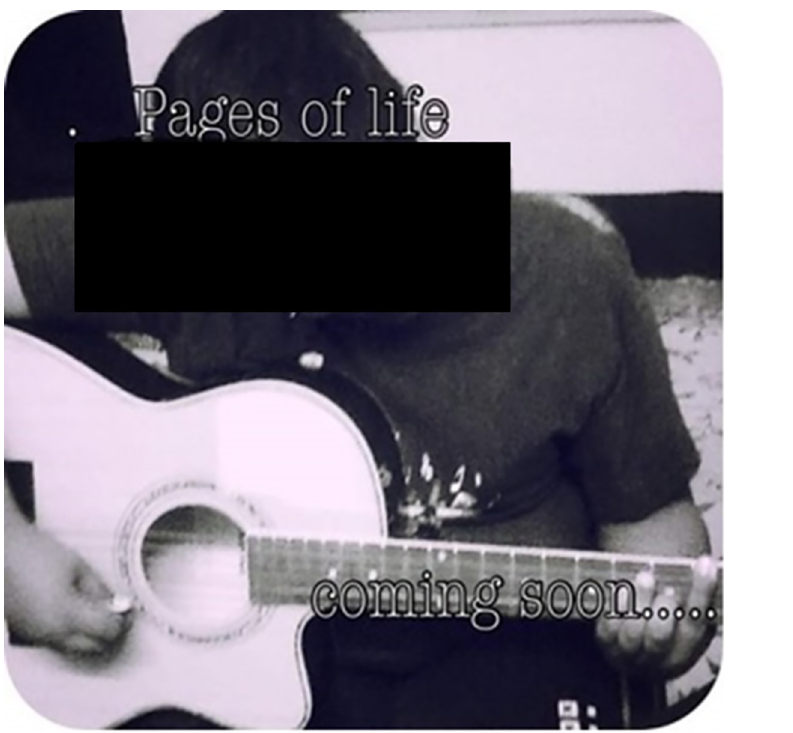
Fig 4. Follow your passion—Music © B1, male adolescent, 15